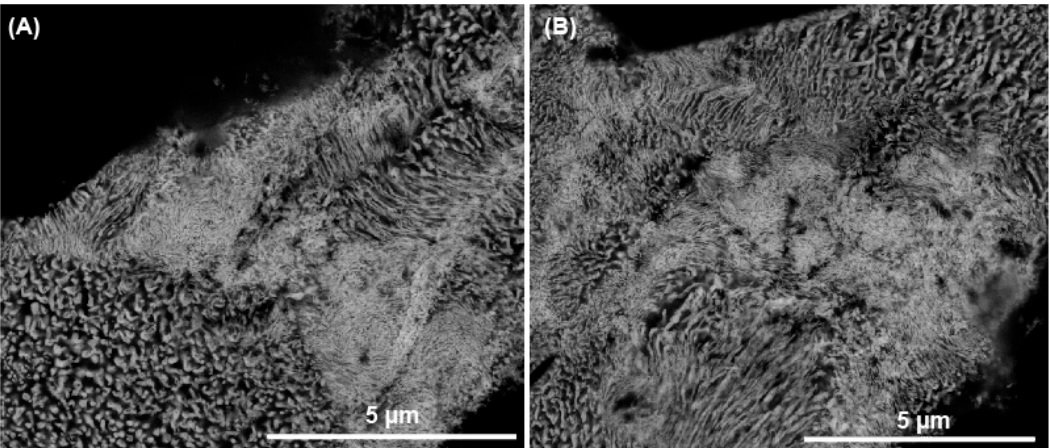
Figure 11. The natural microporous gold found at the Aginskoe deposit, Central Kamchatka epithermal district (imaged by Barbara Etschmann). ( A – B ) Microporous gold grain consists of aggregates of small fibers. The diameters of the gold fibers vary in a single grain.